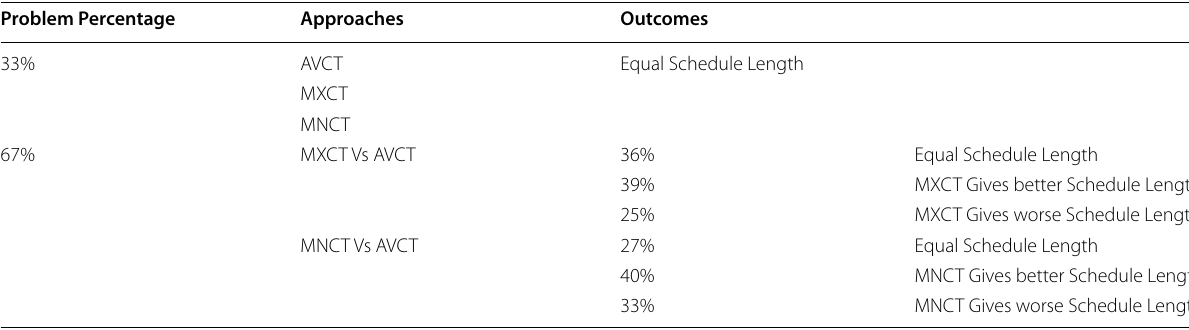
Table 2 Comparison of AVCT, MXCT and MNCT algorithms Problem